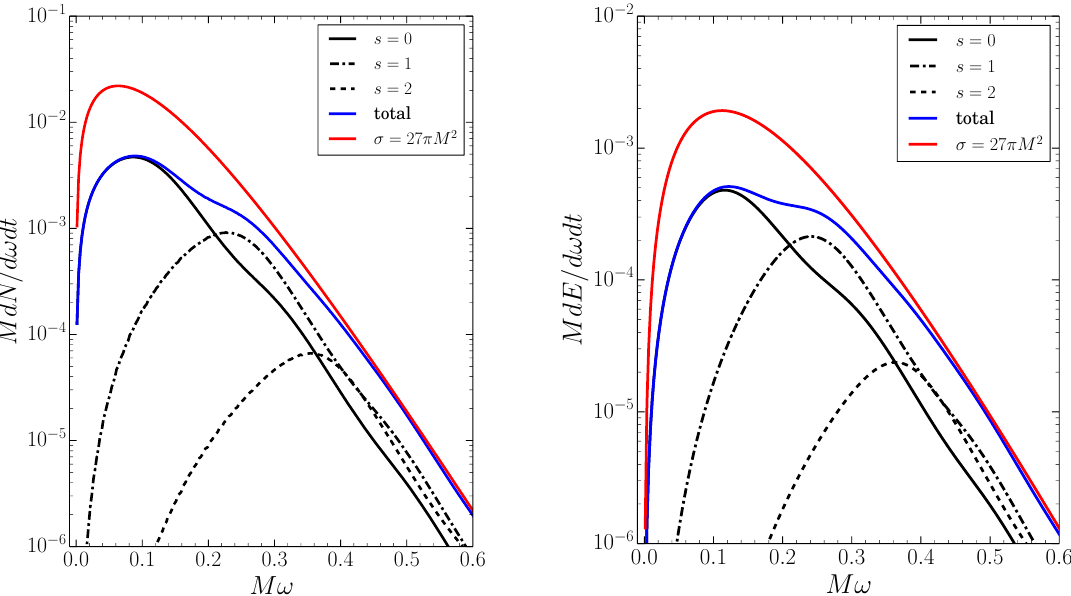
Figure 4. Regge–Wheeler for Schwarzschild: Number and energy spectra . Plots of the number (left) and energy (right) emission spectra for a Schwarzschild black hole, see Equations (21) and (23). Note the logarithmic scale. The emission spectrum is dominated by scalar particles, and emission rates decrease with increasing spin. The total emission rates (i.e. summing over all particle species) are indicated in blue and are bounded by the sums over the geometric optics limit, σ = 27 π M 2 , for each species ∞ . (shown in red), and this limit is approached as M ω →